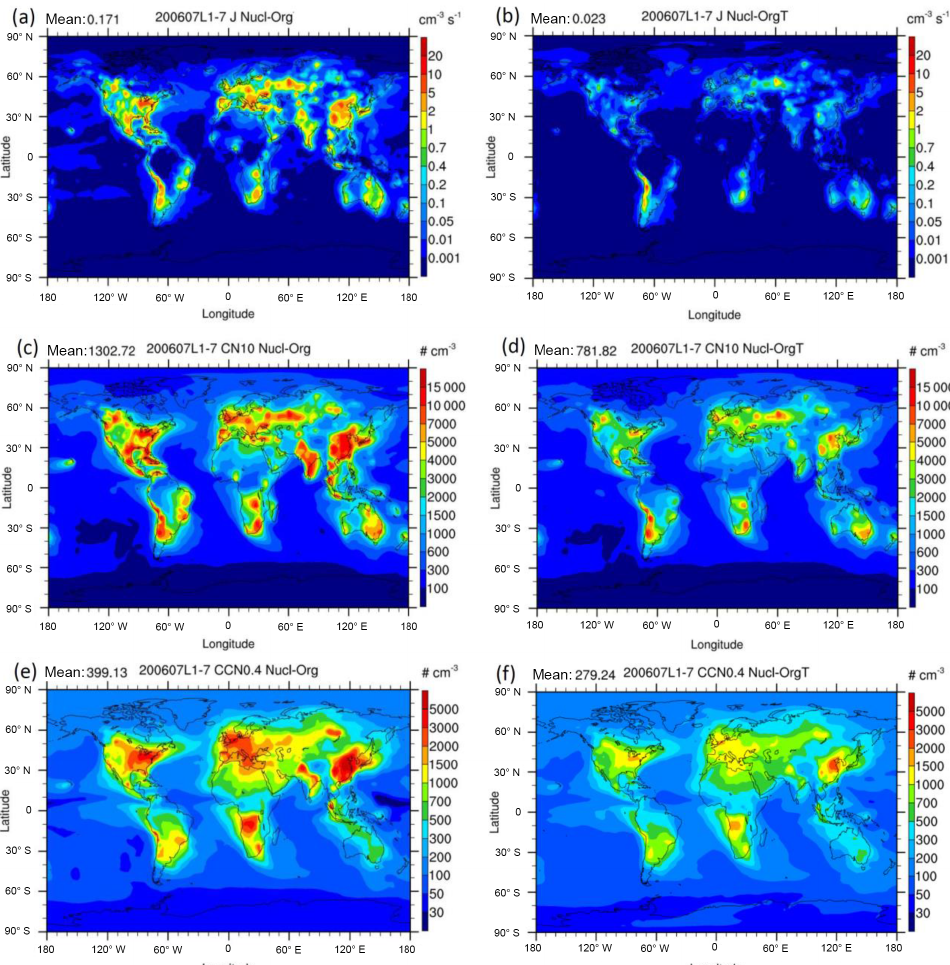
Figure 3. The horizontal distributions of monthly mean nucleation rates ( J ) (a, b) , the concentrations of condensation nuclei larger than 10nm (CN10) (c, d) , and the concentrations of cloud condensation nuclei at a water supersaturation ratio of 0.4% (CCN0.4) (e, f) in the boundary layer (0–1km above the surface) in July 2006 based on two organics-mediated nucleation schemes: J Nucl-Org (left panels) and J Nucl-OrgT (right